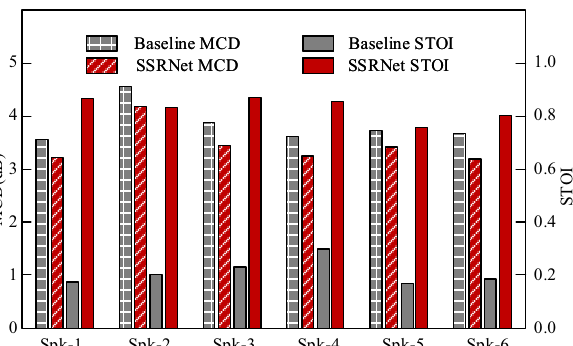
Figure 9. Objective quality comparison between reconstructed voices from the baseline and SSRNet.